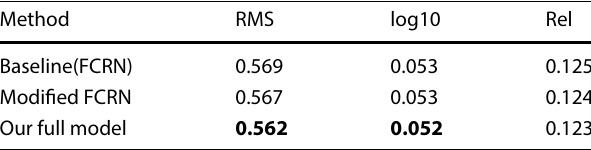
Table 4 Quantitative results of different variants of our method Method